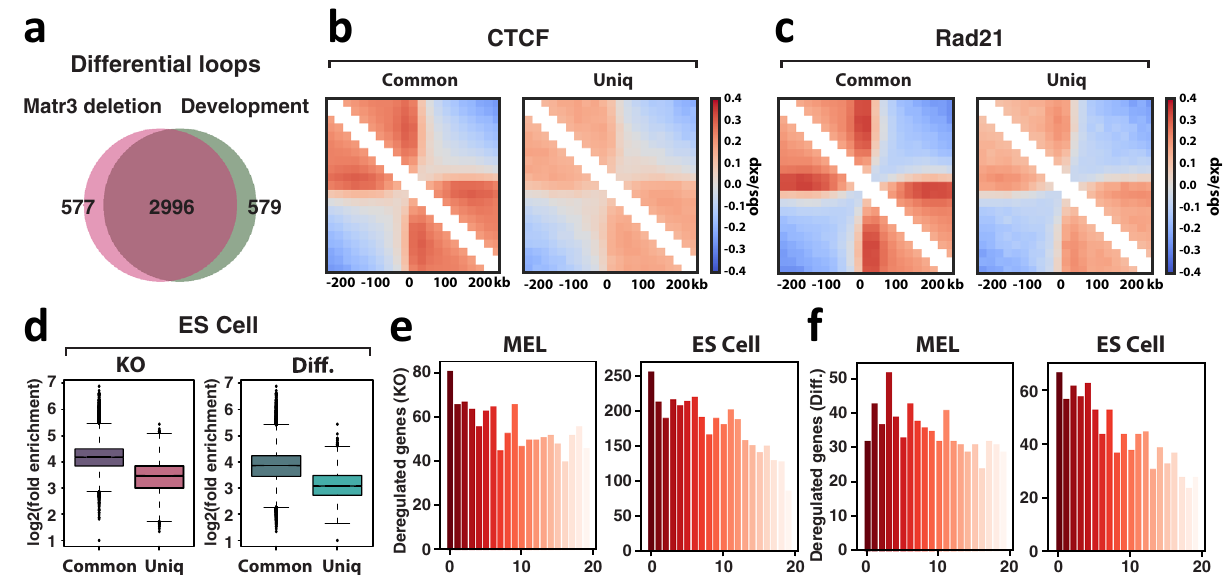
Fig. 7 Impact of Matr3 loss on chromosomal architecture extends to embryonic stem (ES) cells. a 3573 and 3575 differential loops lost in Matr3 KO and during differentiation, respectively, were identi fi ed and signi fi cantly overlapped (2996, 84%). Random overlap for lost differential loops: 212 (out of 3650), 6%, p = 1e-5 from the permutation test. b , c Interaction pile-up maps of Hi-C data at the boundaries de fi ned by each set of CTCF b and Rad21 c ChIP-seq peaks. The normalized pile-up interaction frequency observed over expected values indicates stronger insulation at regions of parental cells that are maintained (common) than at altered sites (uniq) in Matr3 KO cells. The results were con fi rmed in 2-3 independent experiments (Fig. S5i-j). Hi-C data of Matr3 KO compared to parental cells at altered sites are shown in Fig. S6a-b ’ . d ChIP-seq data sets of CTCF in mouse ES cells were quantitatively compared, and the results of independent experiments were combined to generate a more stringent peak list as described above (Fig. S6g). Then, the enrichment of the peaks in each experiment was investigated and con fi rmed (Fig. S6i). CTCF enriched less strongly at altered sites (uniq) than sites maintained (common) in Matr3 KO cells and during differentiation (diff) ( p < 2.2e-16, p < 2.2e-16, respectively, by two-sided t test; Cohen ’ s d = 1.31, Cohen ’ s d = 0.97, respectively). In box plots, the centre line represents the median, box limits show upper and lower quartiles, and whiskers extend to 1.5 × interquartile range. The CTCF peak-mapped genes were placed into ventiles (x-axis) from highest to lowest gene scores corresponding to genes with the most signi fi cant peak changes. The genes within each ventile were then overlapped with genes whose expression was altered (y-axis) in Matr3 KO compared to parental cells e and during differentiation f . Analysis was performed on both MEL and mouse ES cells and the signi fi cance of the association was assessed using the one-sided hypergeometric test ( p = 9.5e-08, p = 2.3e-26, respectively in e and p = 6.6e-04, p = 4.4e-14, respectively in f ).